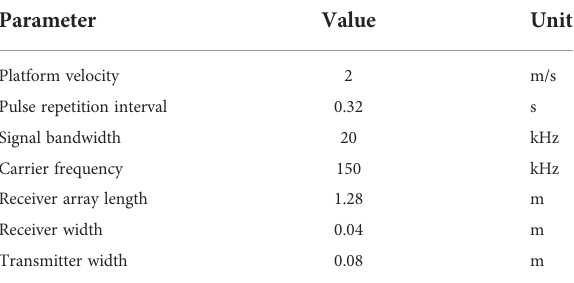
TABLE 1 Synthetic aperture sonar (SAS) parameters.